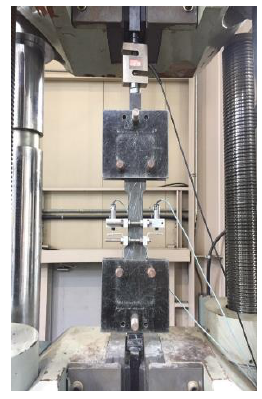
Figure 2. Experimental setup.